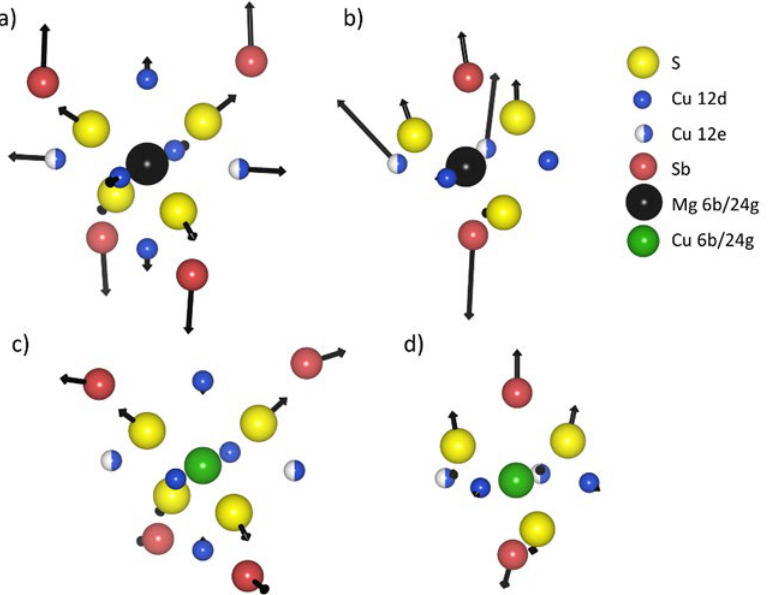
Figure 4. Change of atomic positions of nearest neighbors of a structural void after introducing Mg or Cu atom (Mg and Cu shown as black balls) into the void for: ( a ) Mg in 6b void, ( b ) Mg in 24g void (x = 1.0 magnesium atom per unit cell for both shown examples), ( c ) Cu in 6b void, ( d ) Cu at 24g void (x = 0.5 Cu atom per unit cell for both shown examples). The arrows indicate the direction and magnitude of the shift of the atoms relative to the primary position.